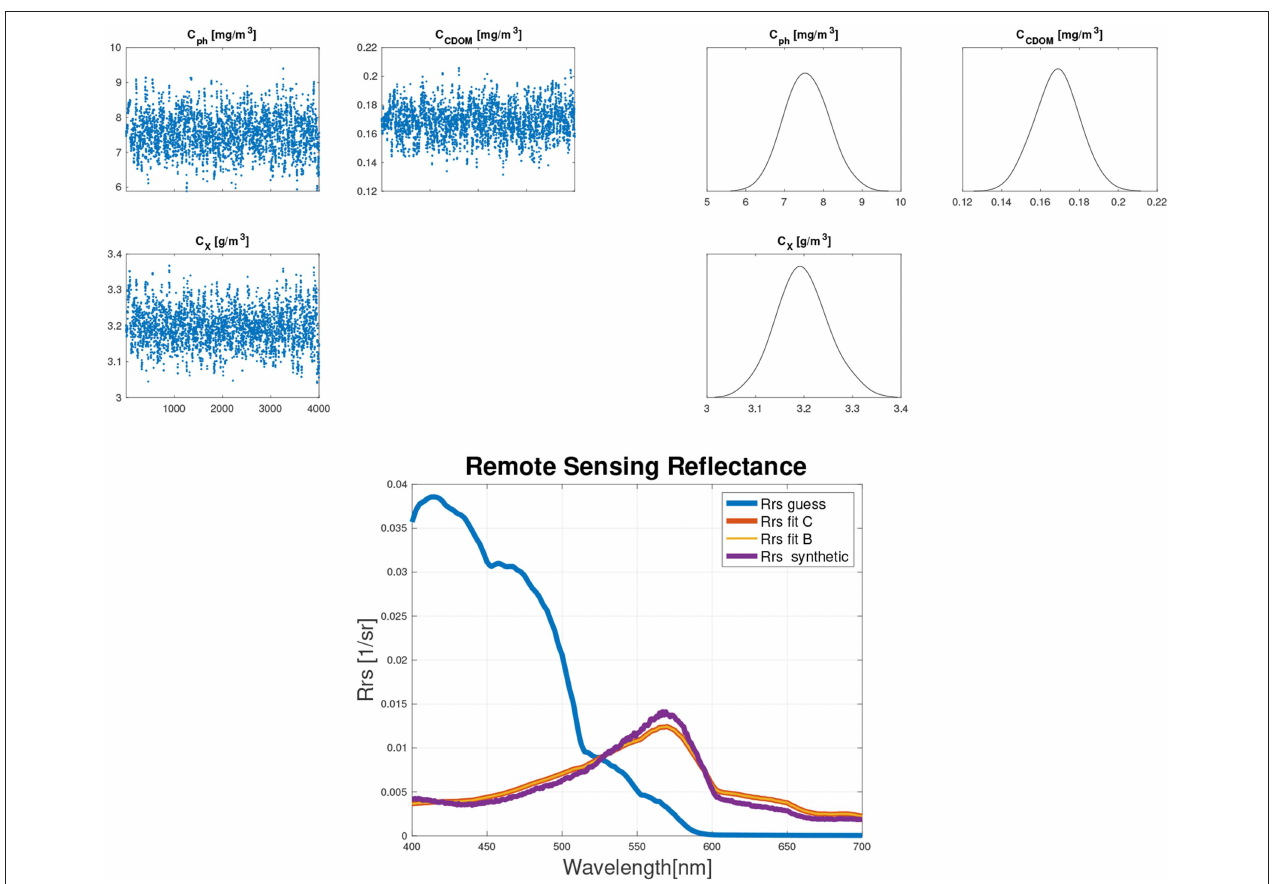
FIGURE 8 | Results for example 2: sampled concentrations, where in the x–axis the number of MCMC samples are reported (top–left) , posterior distributions (top–right) , and real remote sensing reflectance vs. simulated ones (bottom)